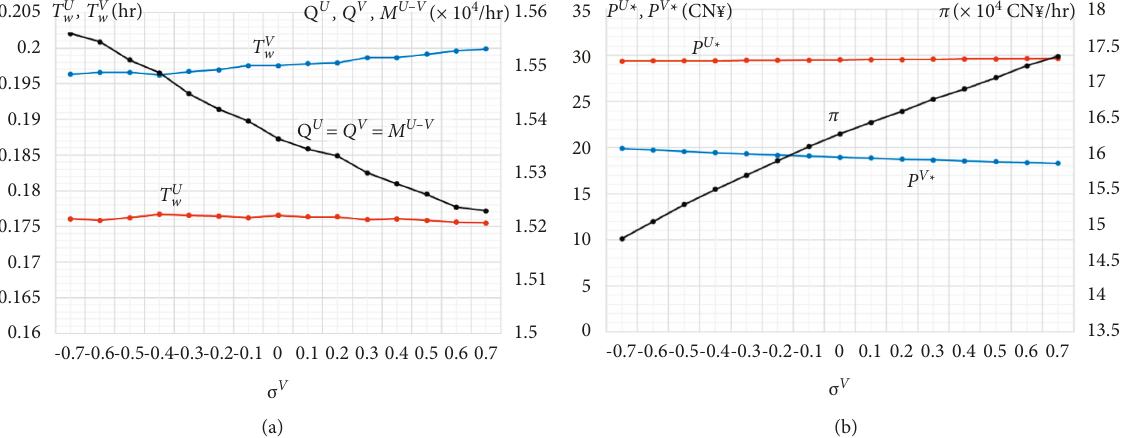
Figure 5: Sensitivity analysis with respect to drivers’ correlation coefficient. (a) Changes in T U P V ∗ , and π